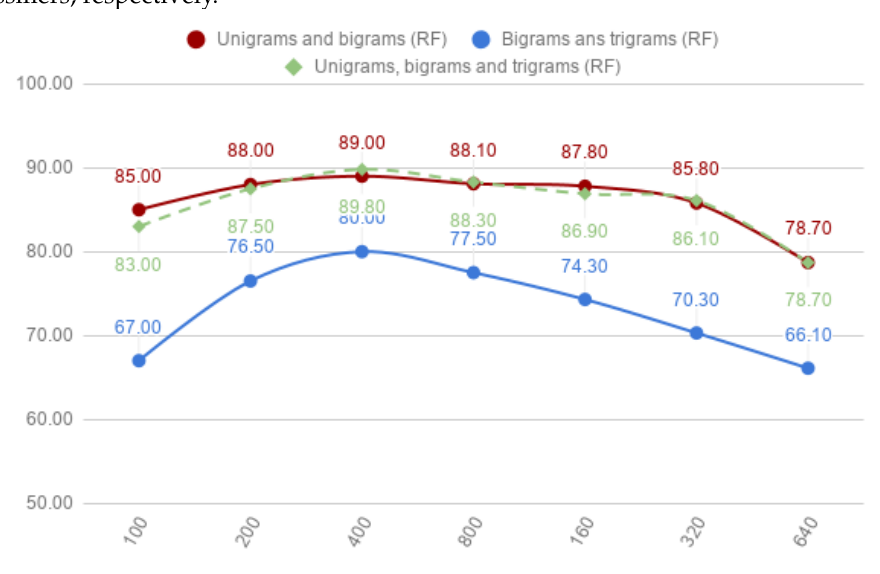
Figure 6. Combinations of unigrams and bigrams, bigrams and trigrams, and unigrams, bigrams and trigrams for the random-forest (RF) classifier.